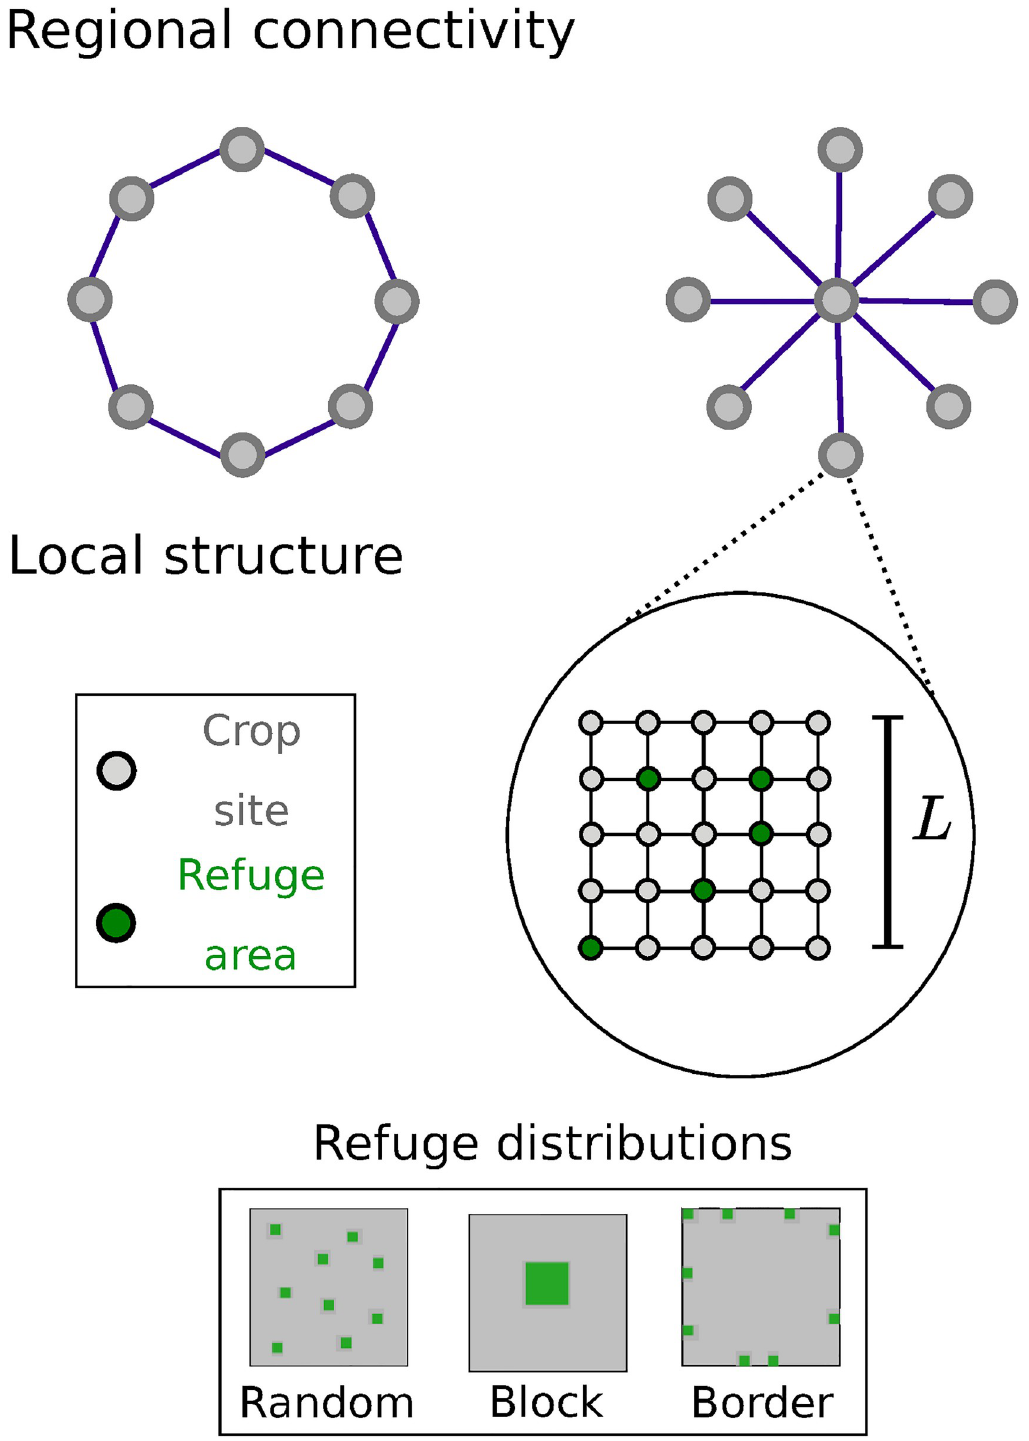
Fig 1. Local and regional spatial structures. Illustration of spatial structuring in the model, showing two different scales. On the regional scale, connectivity is represented by an external network, where network nodes are connected as ring or star topologies. Each of these nodes corresponds to a regular square lattice on the local scale, with patches assigned two types: crop or refuge (non-crop) areas. For each proportion of refuge areas on the lattice, three refuge distributions are considered: random, block, and